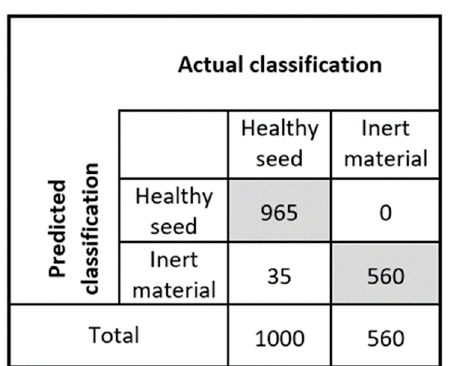
Figure 9. Confusion matrix of test data set from the developed model.